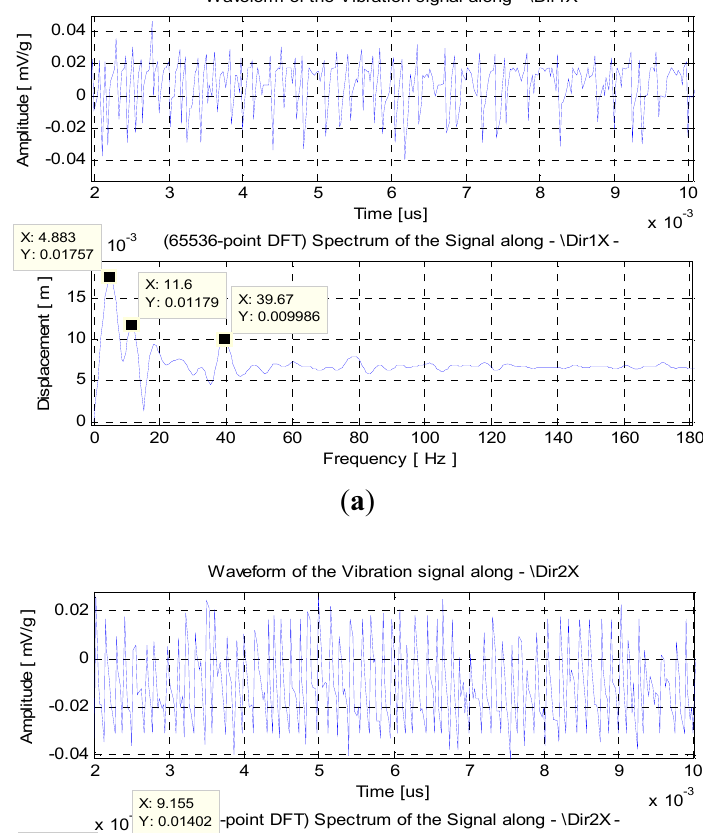
; ( b ) Signal at S 1